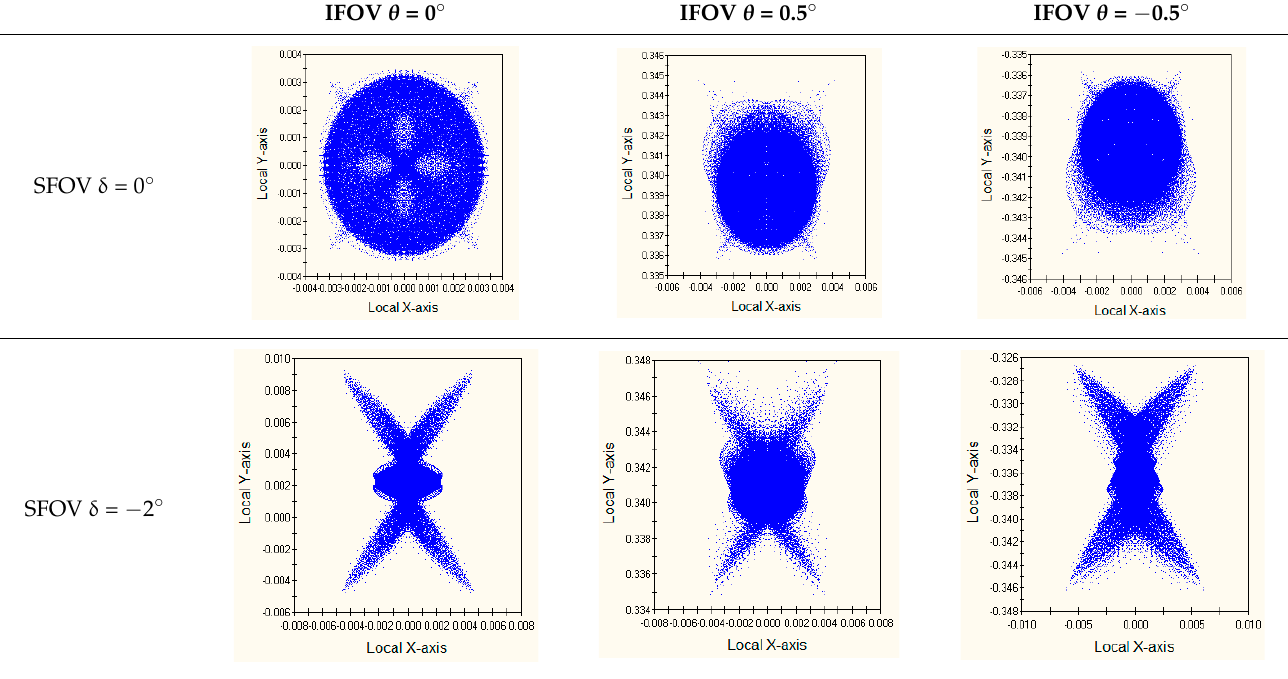
Table 6. Imaging for different SFOV and IFOV values in different bands.